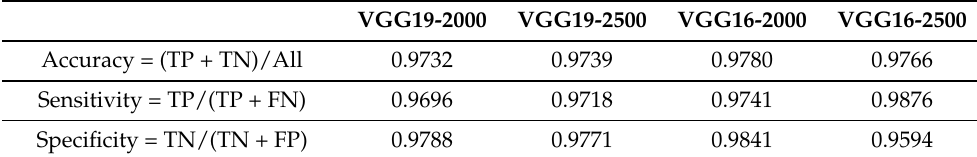
Table 4. Accuracy, sensitivity, and specificity for the validation set.